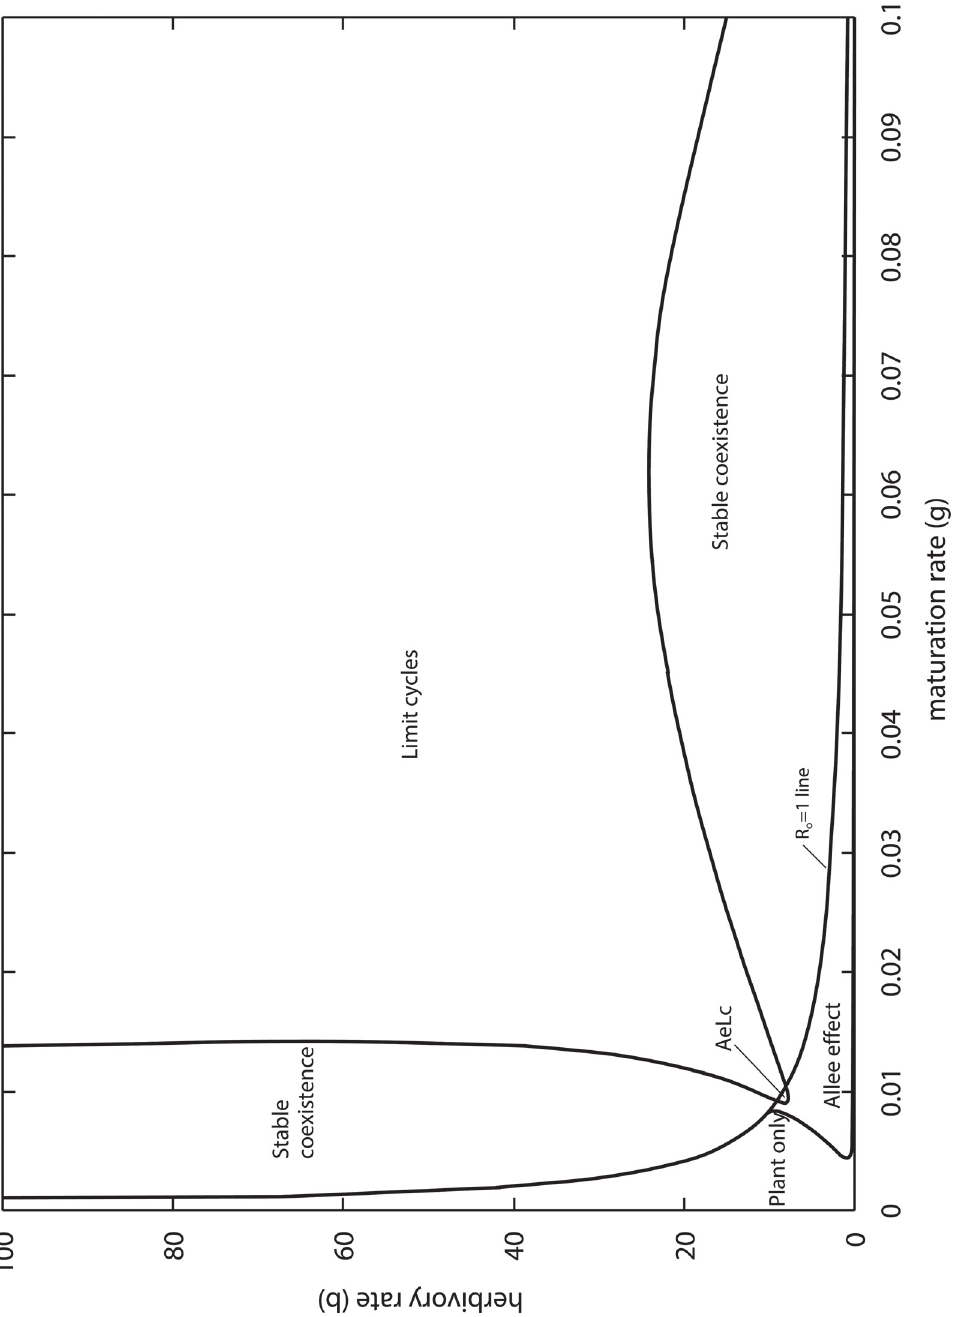
Fig 4. Outcomes of the PLA model as a function of the larval maturation and herbivory rates for generalist pollinators ( ϕ = 1). AeLc: intersection of the Allee effect and Limit cycle